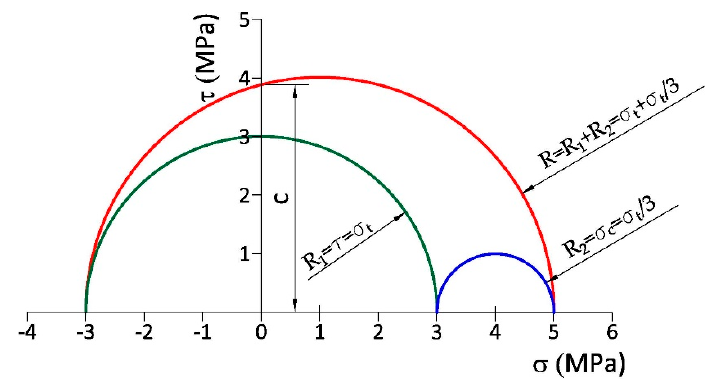
Figure 7. Mohr circle for the Brazilian test of concrete: σ t = 3 MPa and c = 3.9 MPa.